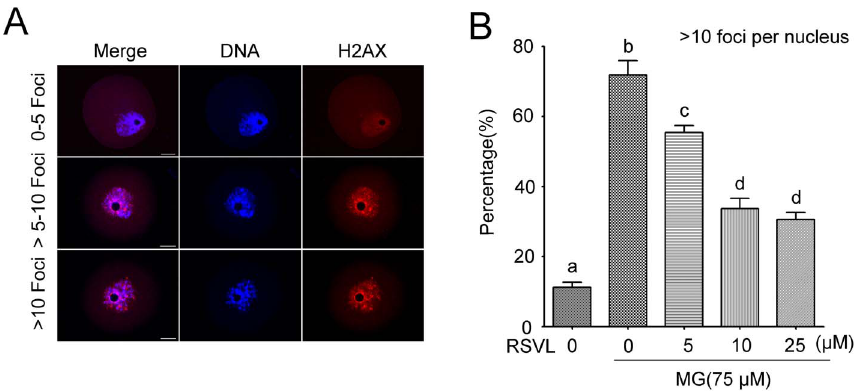
Figure 1. Induction of c -H2AX foci in GV oocytes following MG and resveratrol (RSVL) treatment. Oocytes were blocked at the GV stage in M2 medium plus 2.5 m M milrinone and were cultured with or without 75 m M MG and different concentration of resveratrol for 6 h. DNA and c - H2AX were stained and the results show that resveratrol can effectively protect MG-induced the formation of c -H2AX, the protein marker of DSB. ( A ) Representative samples of control GV-stage oocytes with c -H2AX 0–5 foci, . 5–10 foci and . 10 foci. Red, c -H2AX; Blue, DNA. Scale bar =20 m m. ( B ) The proportion of GV oocytes with c -H2AX . 10 foci after MG and different concentration of resveratrol treatment (5, 10 and 25 m M). Data are mean 6 SEM of three independent experiments. Different letters denote statistically significant differences ( P ,